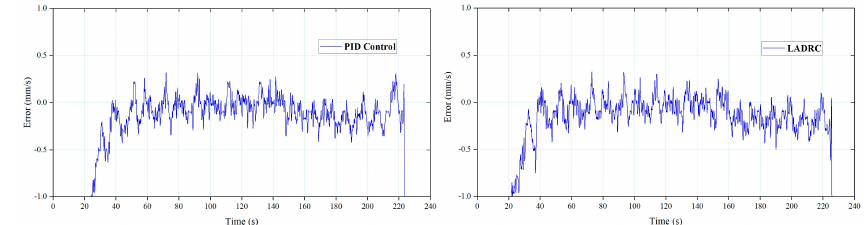
Figure 17. Speed error of cylinder #1 during unfolding.